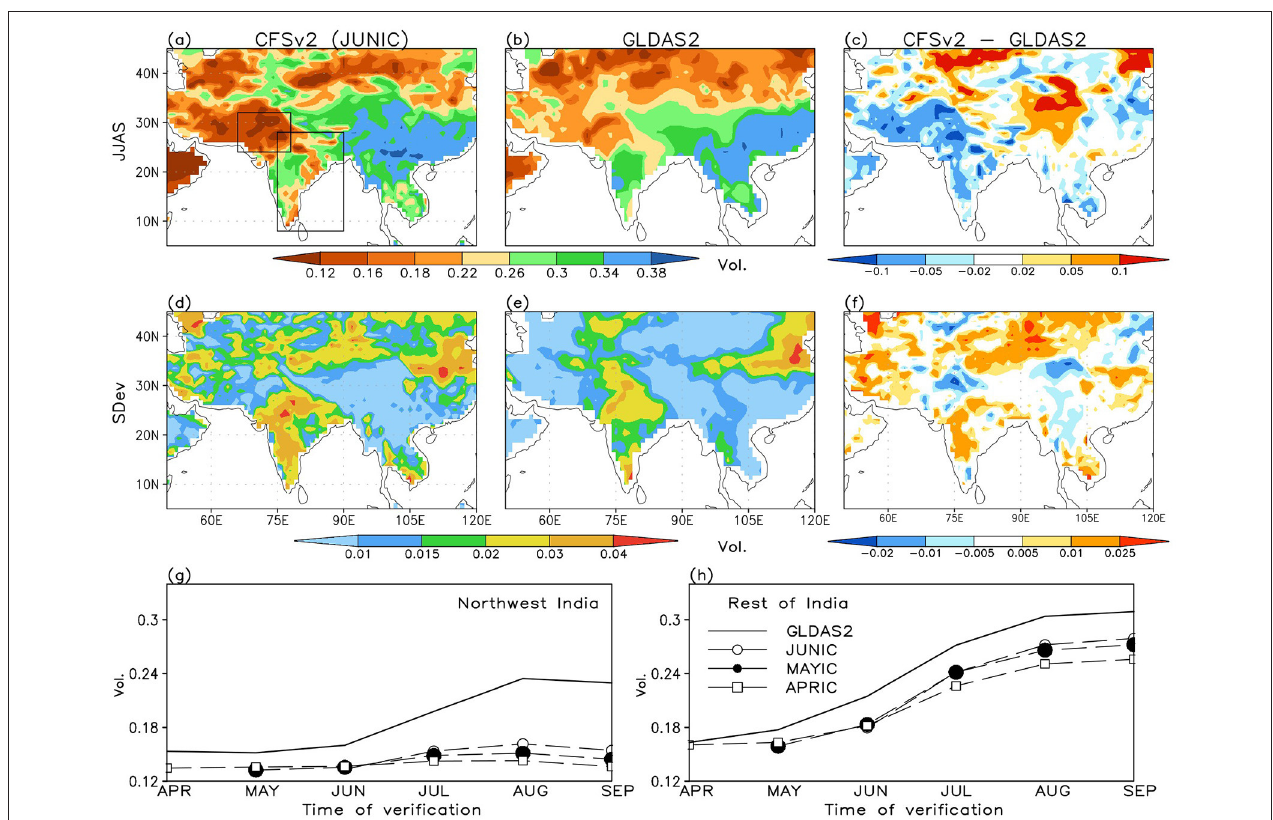
FIGURE 2 | Same as in Figure 1 , except for top 1m soil moisture. Observations are from the GLDAS2. Units are